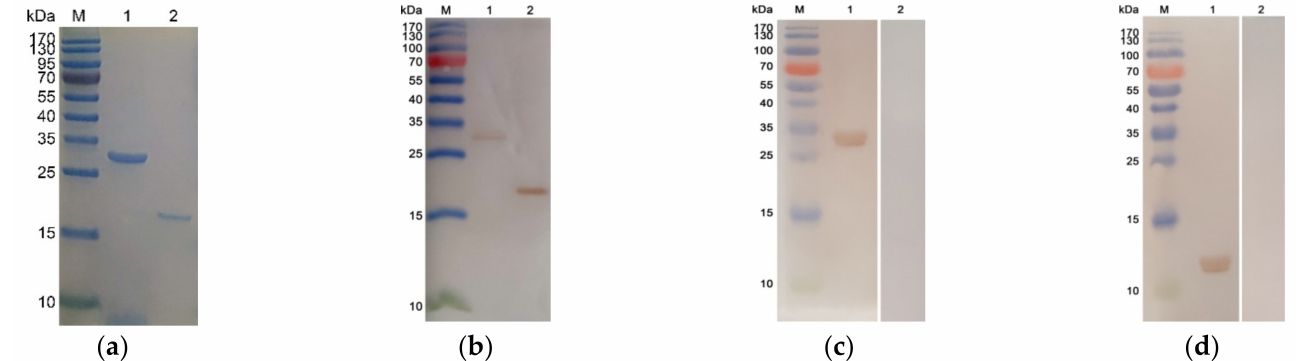
Figure 1. The results of sodium salt polyacrylamide gel electrophoresis (SDS-PAGE) and Western blot analysis. Line M: protein molecular weight marker. ( a ) SDS-PAGE analysis of the purified recombinant Toxoplasma gondii ribosomal protein P2 (TgRPP2) and the pET32a vector protein. Line 1: purified recombinant TgRPP2 (rTgRPP2) protein. Line 2: purified pET32a vector protein. ( b ) Western blotting of recombinant TgRPP2 and the pET32a vector protein. rTgRPP2 (Line 1) and pET32a vector protein (Line 2) probed by a mouse anti-His-tagged antibody as the primary antibody. ( c ) Western blot of recombinant TgRPP2. Line M: protein molecular weight marker; Line 1: rTgRPP2 probed by serum from rats against T. gondii as the primary antibody; Line 2: rTgRPP2 probed by sera from normal rats as the primary antibody. ( d ) Western blotting of native TgRPP2. Line M: protein molecular weight marker. Line 1: total soluble protein of T. gondii tachyzoites probed by sera from rats immunized by rTgRPP2 as the primary antibody. Line 2: total soluble protein of T. gondii tachyzoites probed by sera from normal rats as the primary antibody.